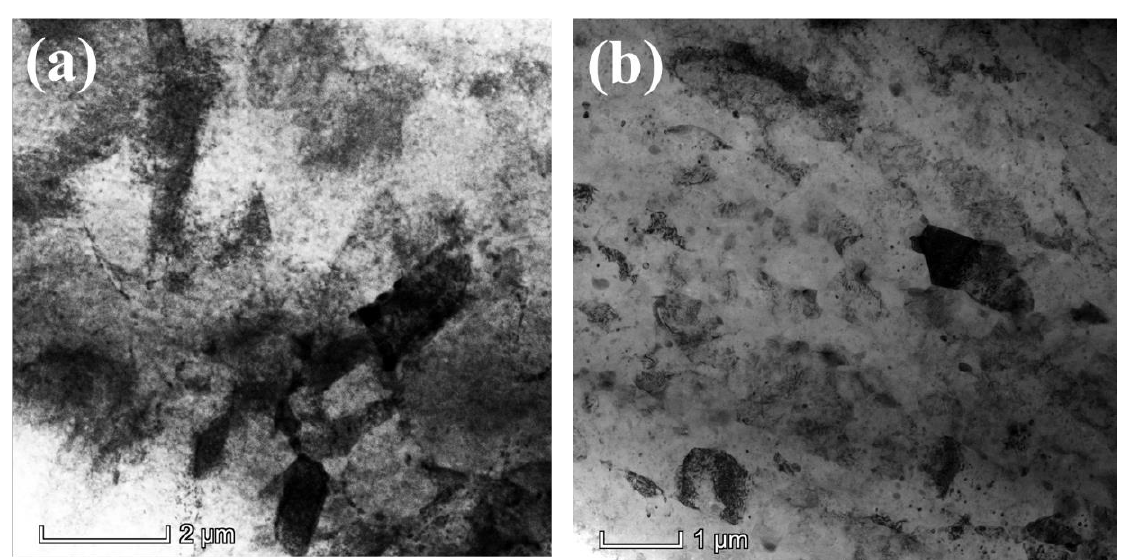
Figure 5. Bright-field TEM images of cross-section morphologies after 100 °C compression, ( a ) cryogenic conventionally rolled alloy; ( b ) cryogenic MD-rolled alloy.